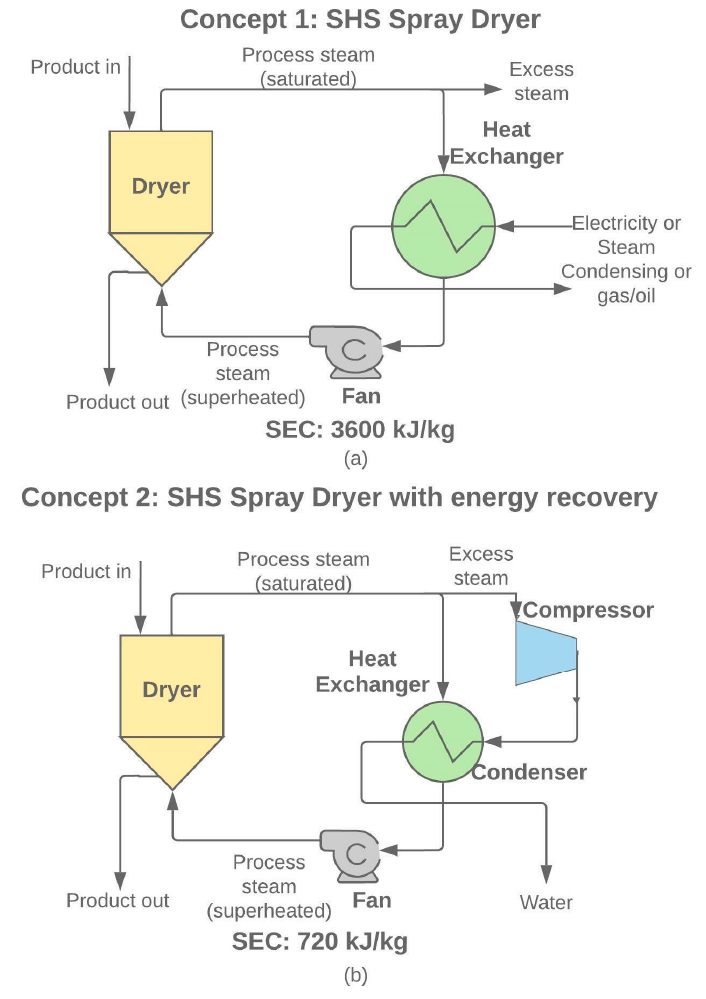
Figure 4. Different configuration of SHS spray dryers: ( a ) standard SHS spray dryer and; ( b ) SHS spray dryer with energy recovery (Based on [65]).